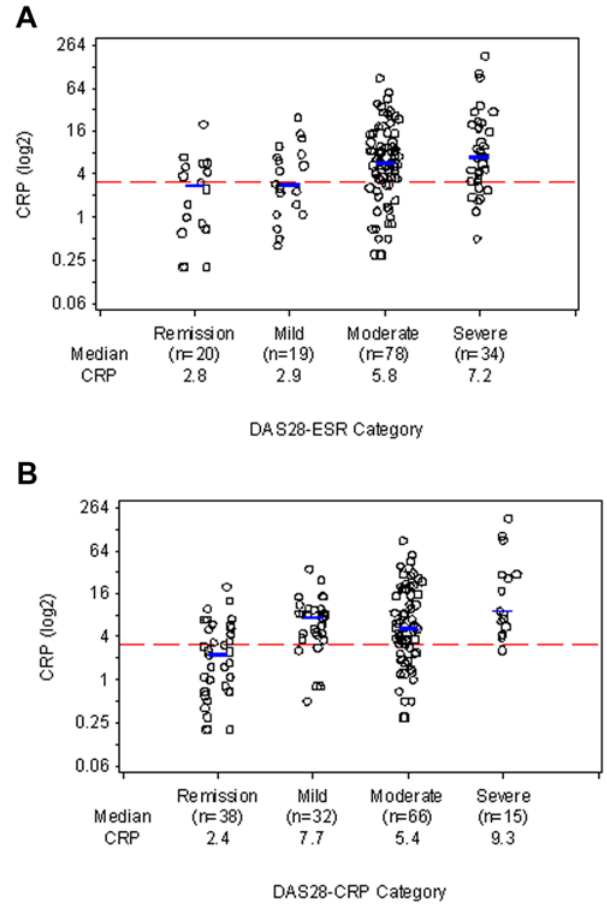
Figure 4. CRP Levels by Disease Activity as determined by (a) DAS28-ESR and (b) DAS28-CRP. CRP (log2) values are shown within each swollen joint count category. CRP levels and DAS28 were determined at the same clinic visit. Blue lines denote location of median. Dotted reference line is at CRP=3 mg/L.